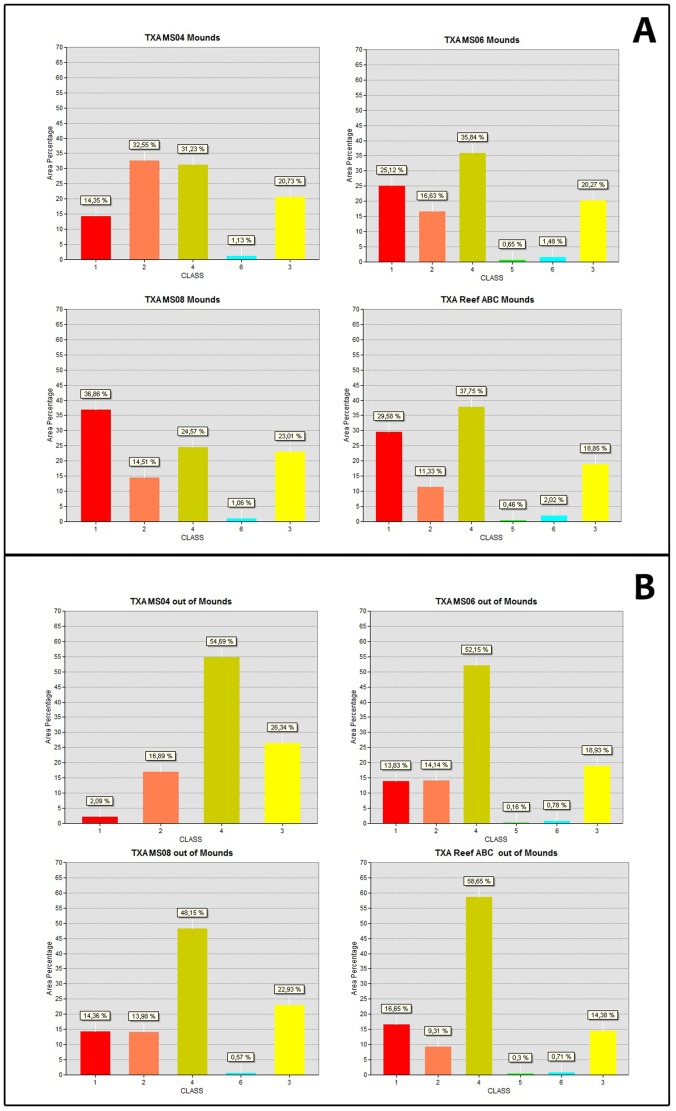
Graphs representing the classified results of the SSS mosaics (Figures 3 and 10) within (A) mound and (B) intermound areas.